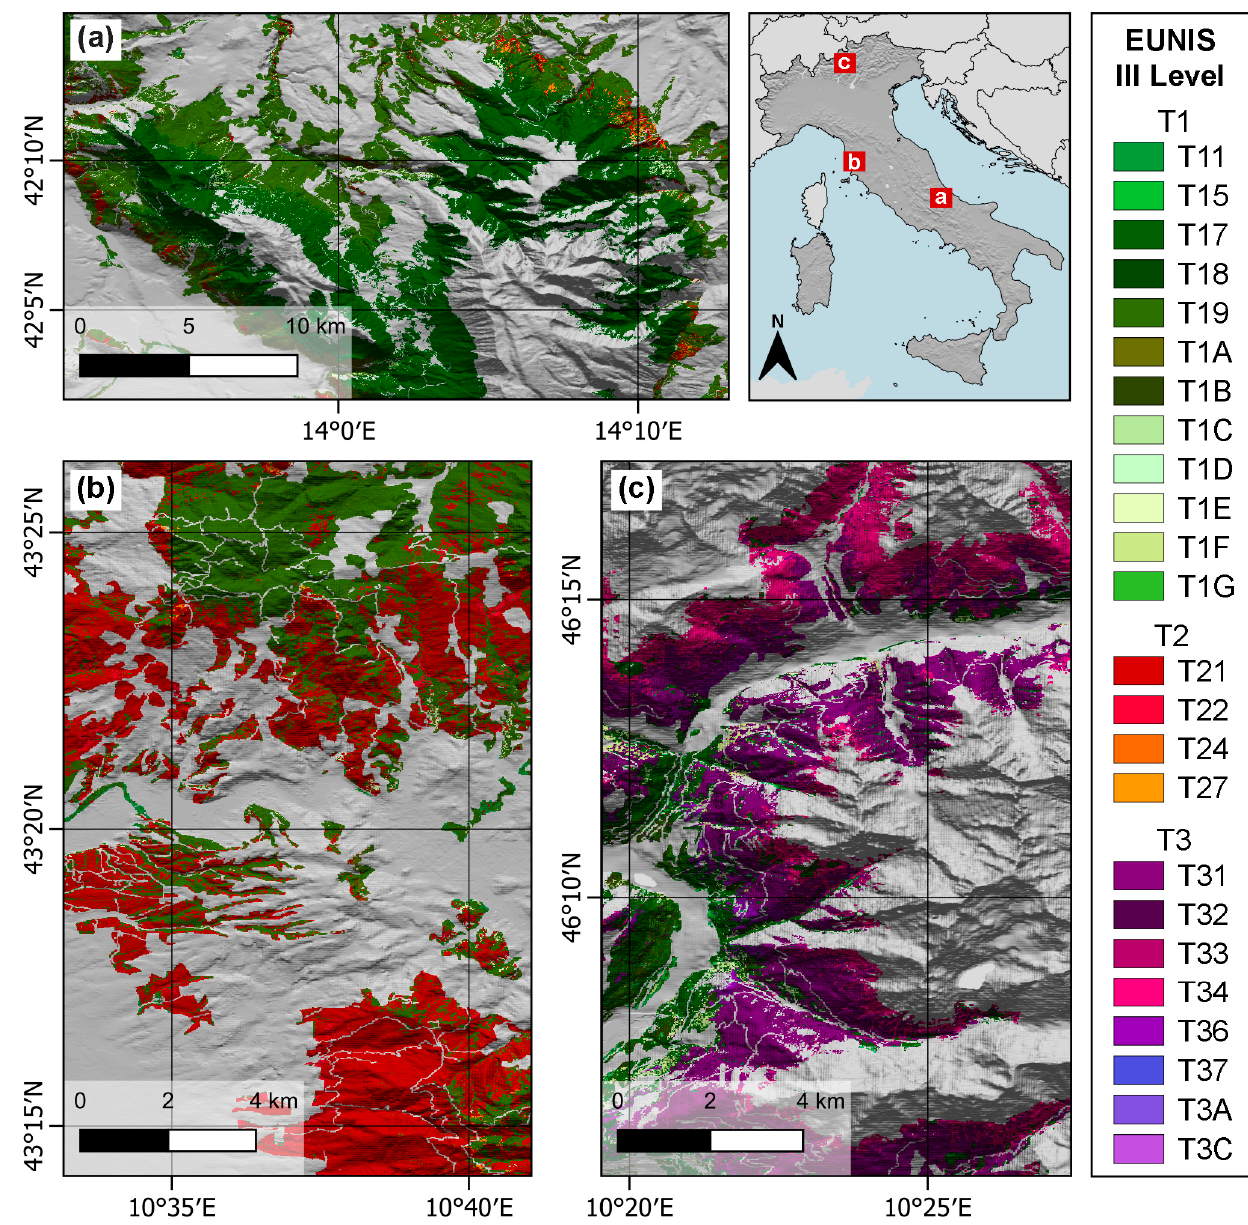
Figure 6. Local spatial extent of: ( a ) T1 broadleaved deciduous forest on central Italy; ( b ) T2 broadleaved evergreen forest along Tyrrhenian coast on central Italy; and, ( c ) T3 needleleaved forest habitat in the Alps on northern Italy. For the code reference of the legend, see Table 3.